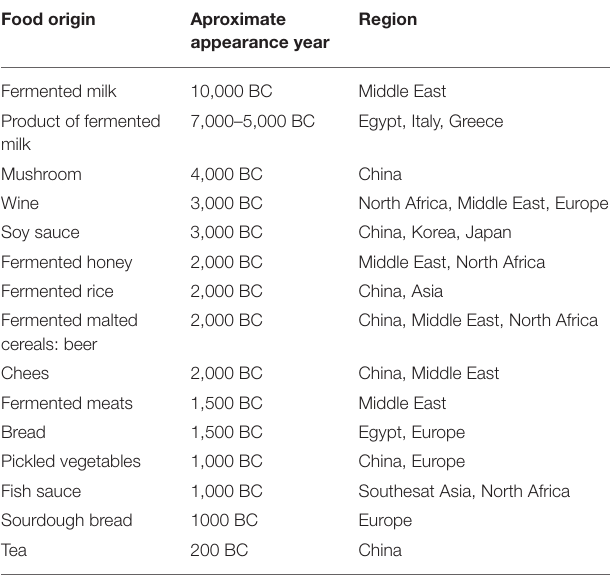
TABLE 1 | Some fermented foods history and